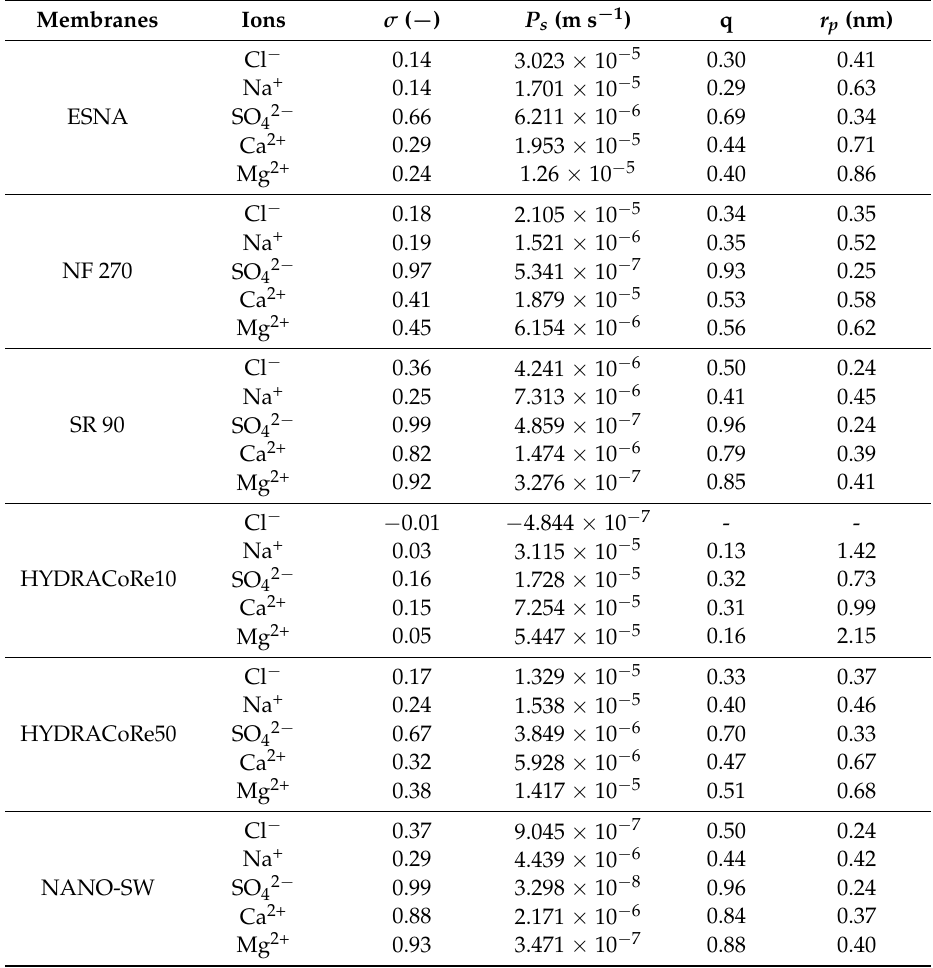
Table 4. Calculated σ , P s , and average r p for ions for all tested membranes.